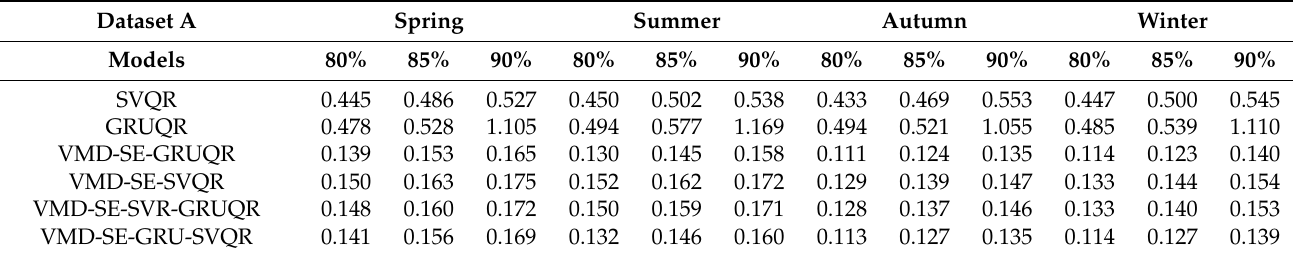
Table 5. MC values in dataset A at three confidence levels.